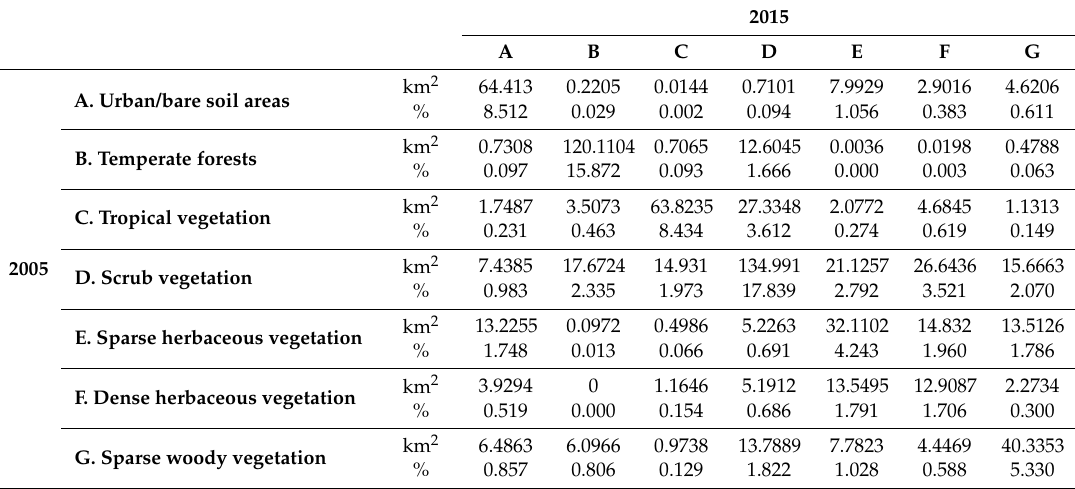
Table 16. Matrix of land use-cover changes from 2005 to 2015, in the adjacent area of Natural Protected Area Altas Cumbres (NPAAC). Victoria, Tamaulipas, Mexico.